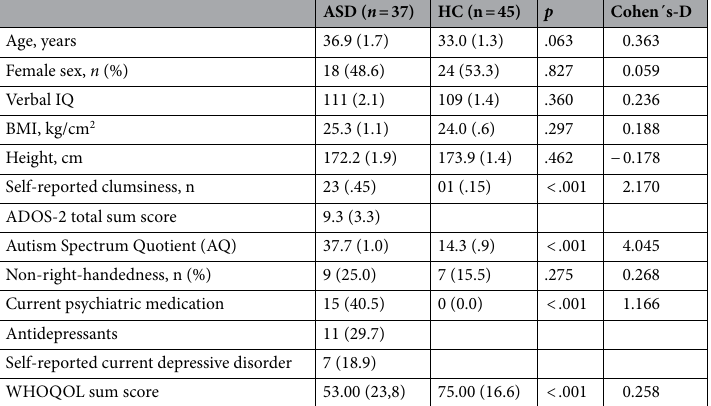
Table 3. Clinical and demographic data of